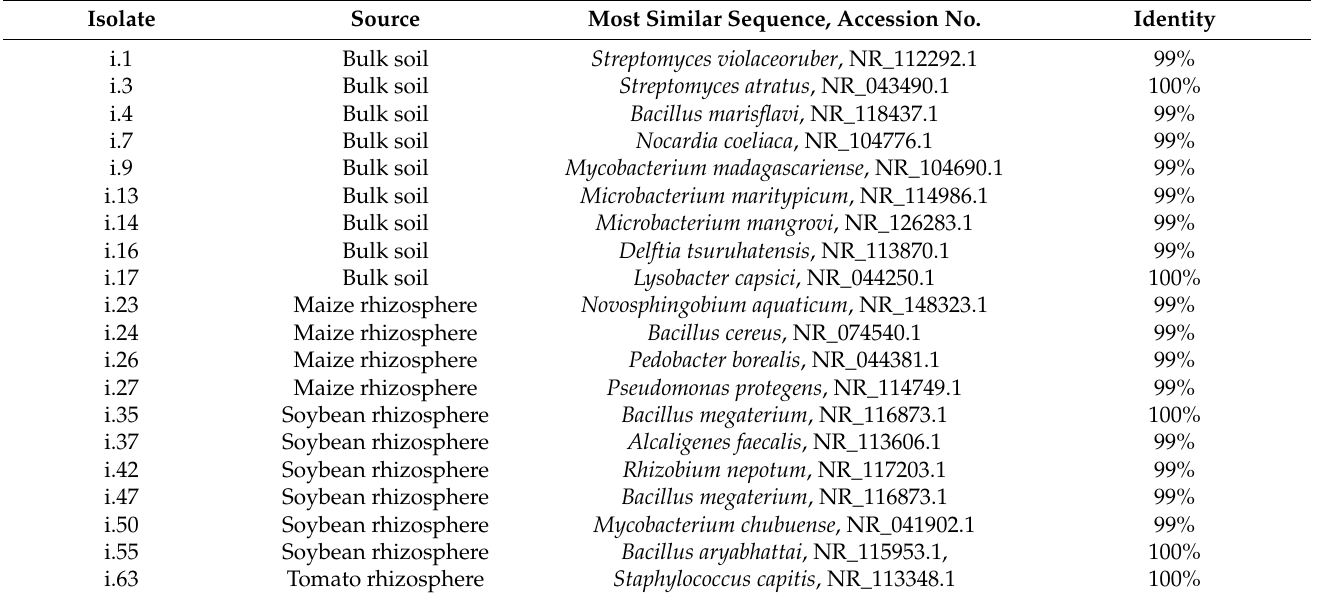
Table 1. Taxonomic assignment of bacterial strains that were isolated from the cuticle of Pratylenchus penetrans after baiting in suspensions of bulk soil or different rhizosphere